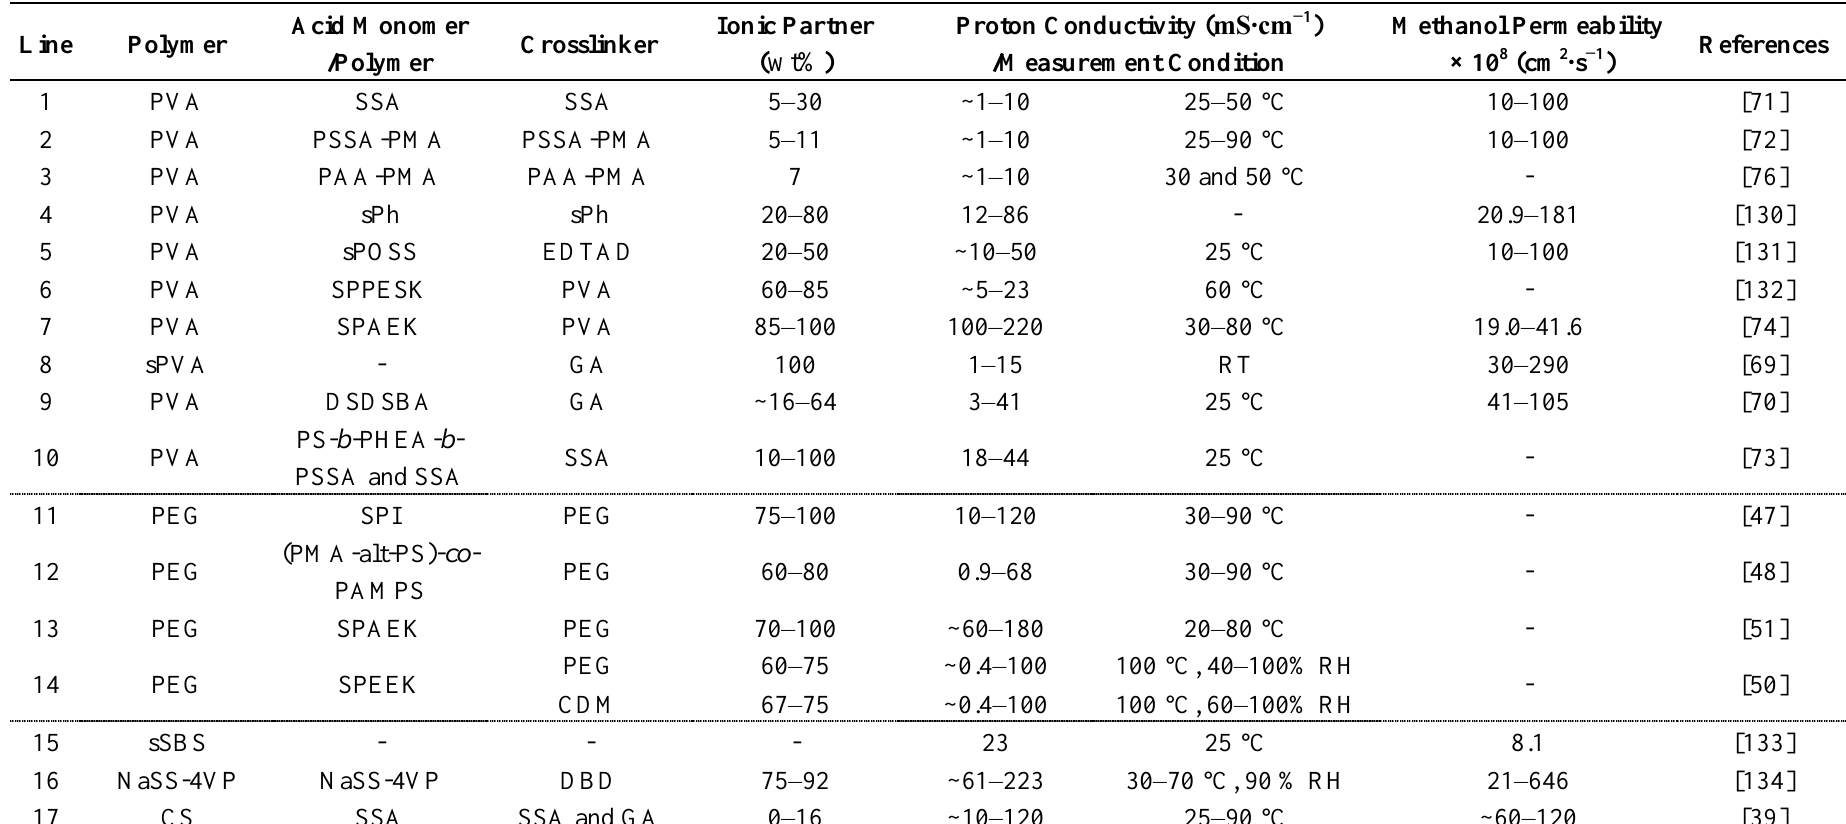
Table 4. Characteristics of various crosslinked membranes that incorporate water soluble